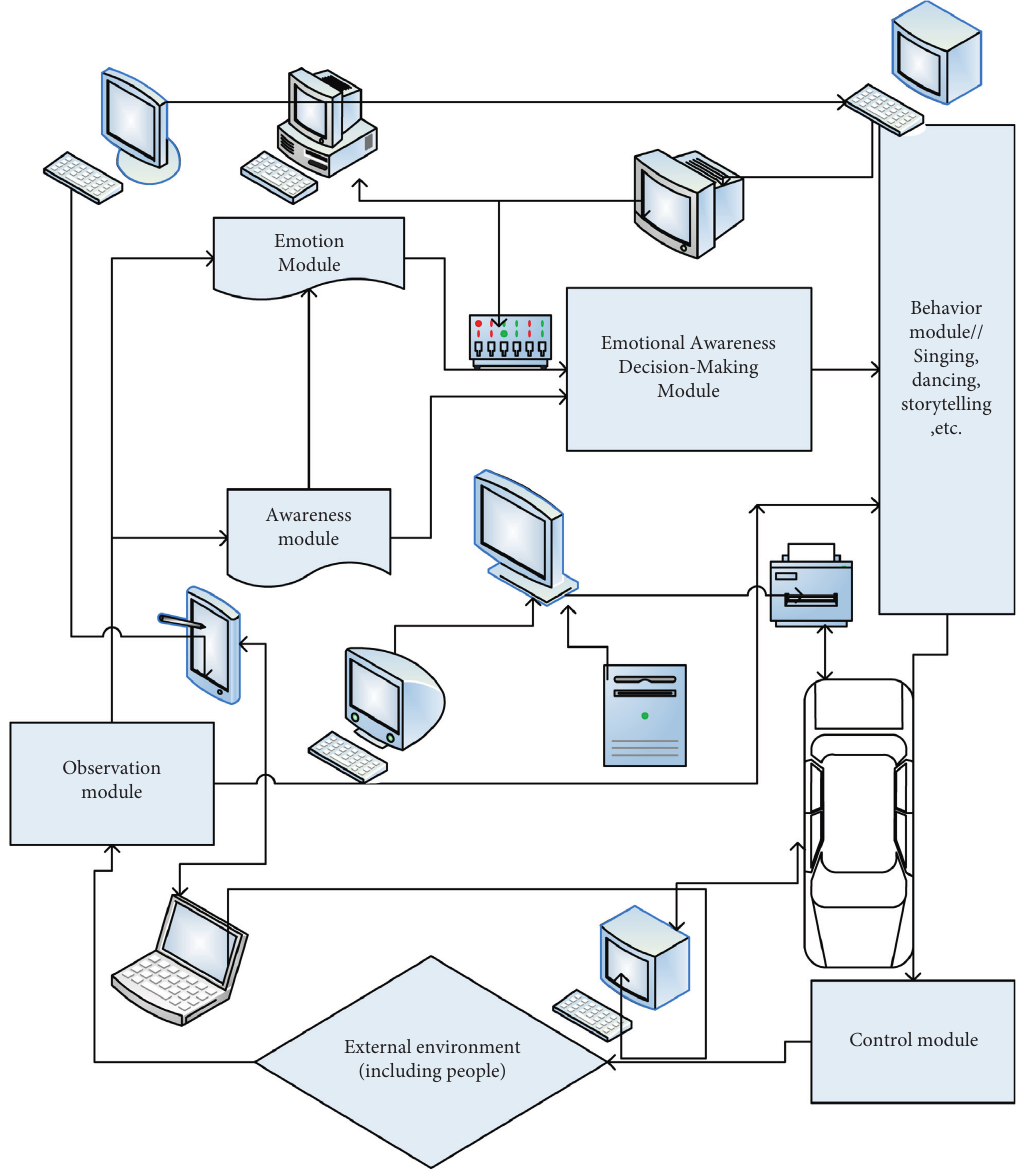
Figure 1: AC model basic frame structure